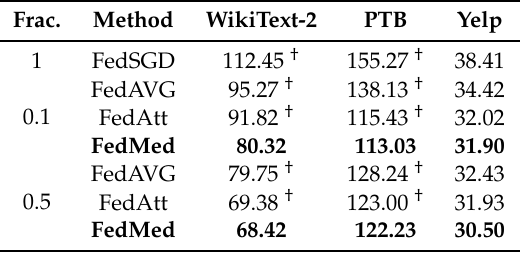
Table 2. Test perplexity using LSTM-base model by FedSGD, FedAvg, FedAtt and FedMed methods. The symbol † represents the results disclosed by earlier publications.